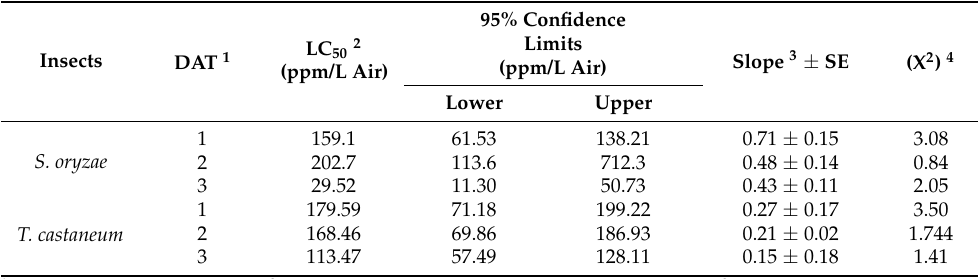
Table 7. The LC 50 values of S. chinensis oil against S. oryzae and T. castaneum adults following the fumigation bioassay.